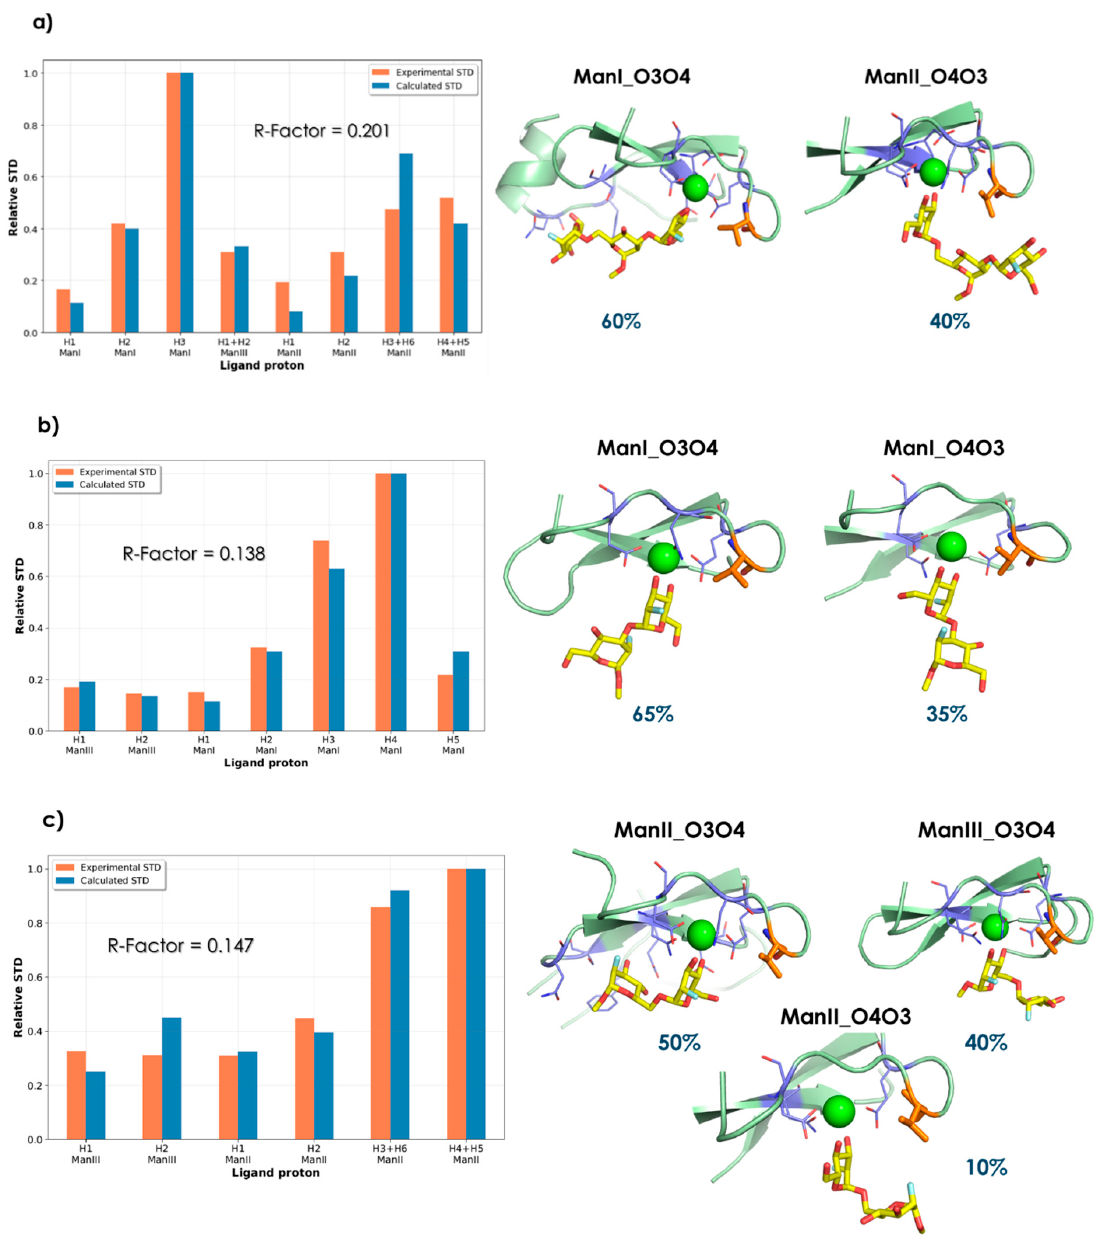
Figure 4. Contributions of the individual binding modes that provide the best fit to the experimental STD NMR data. Representative structures along with the associated NOE R-Factor rel of the best binding mode combination found for compounds 1a , 2b, and 3c are shown. Val351, which is the only aliphatic residue at the lectin binding site, is colored in orange.